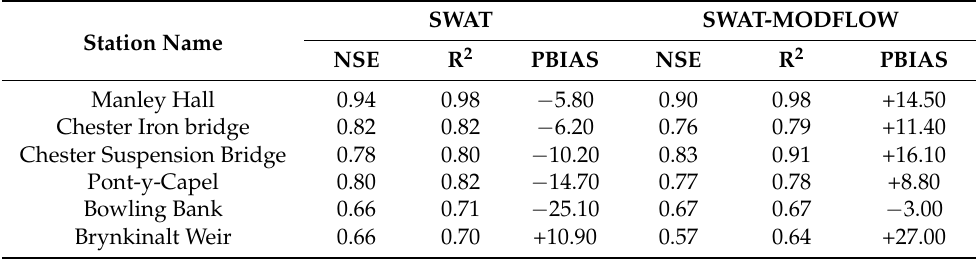
Table 4. Performance statistics of the standalone SWAT model and the coupled SWAT-MODFLOW model for the validation period of 2001–2003 for streamflow.